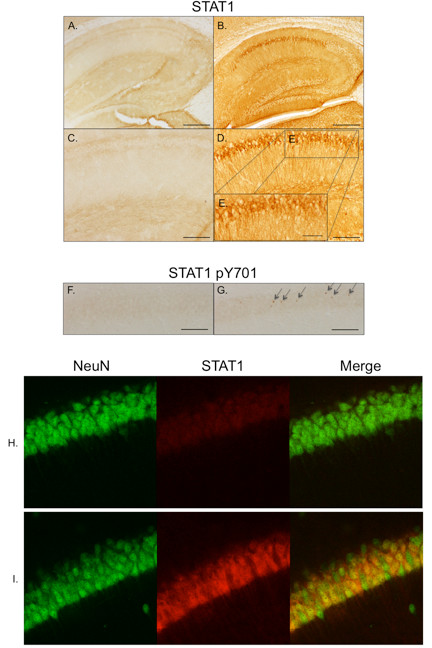
STAT1 expression occurs in neurons of the CA1 region of the hippocampus in AblPP/tTA mice prior to neuronal loss. (A-E) STAT1 immunohistochemistry of the CA1 region of an AblPP/tTA mouse expressing constitutively active c-Abl for 3 weeks (B,D,E) versus wild-type control (A,C). (F,G) STAT1pY701 immunohistochemistry the CA1 region of a wild-type mouse (F) versus an AblPP/tTA mouse 3 weeks off doxycyline (G). Cells positive for STAT1 pY701 are indicated with arrows. (H,I) Double labeling with NeuN (green) and total STAT1 (red) in wild-type (panel H) and AblPP mice expressing constitutively active c-Abl for 2 weeks (panel I). Scalebars: A,B = 2 mm; C,D,F,G = 800 μm; E = 400 μm.